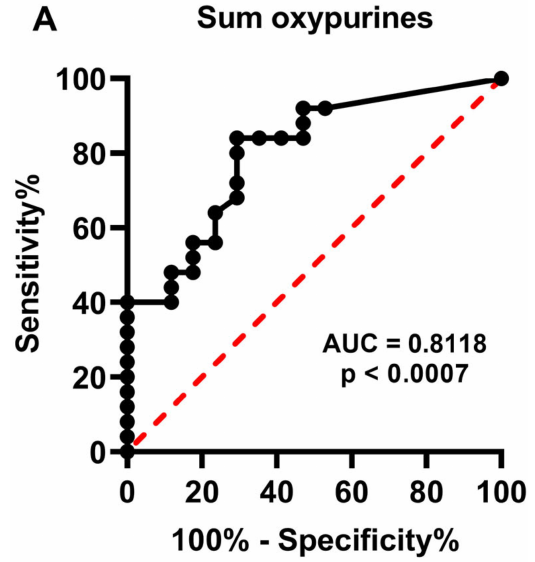
Figure 6. Receiver Operating Characteristic (ROC) curves of nitrite ( A ), nitrate ( B ), and nitrite + nitrate ( C ) determined in the culture media of the two groups of human embryos cate- gorized according to morphological quality using the Gardner scale system. The significance of the Area Under the Curve (AUC) is indicated in each